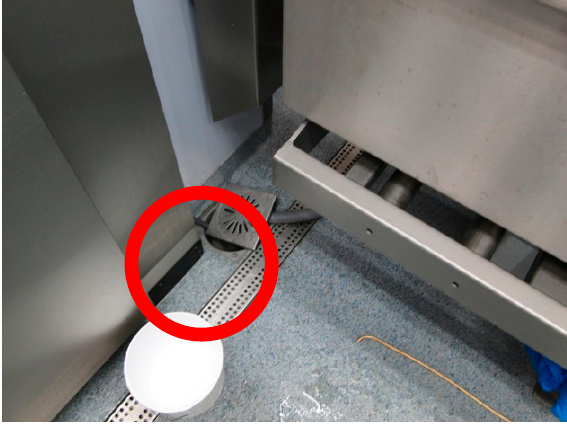
Figure 6. In the storage room the DFV system was blocked (red circle), preventing a free flow of air from the plenum to the extraction vent (T-4 in Table 2). Note that the grid in the floor is not for extraction of air; it is used to drain liquid spills.